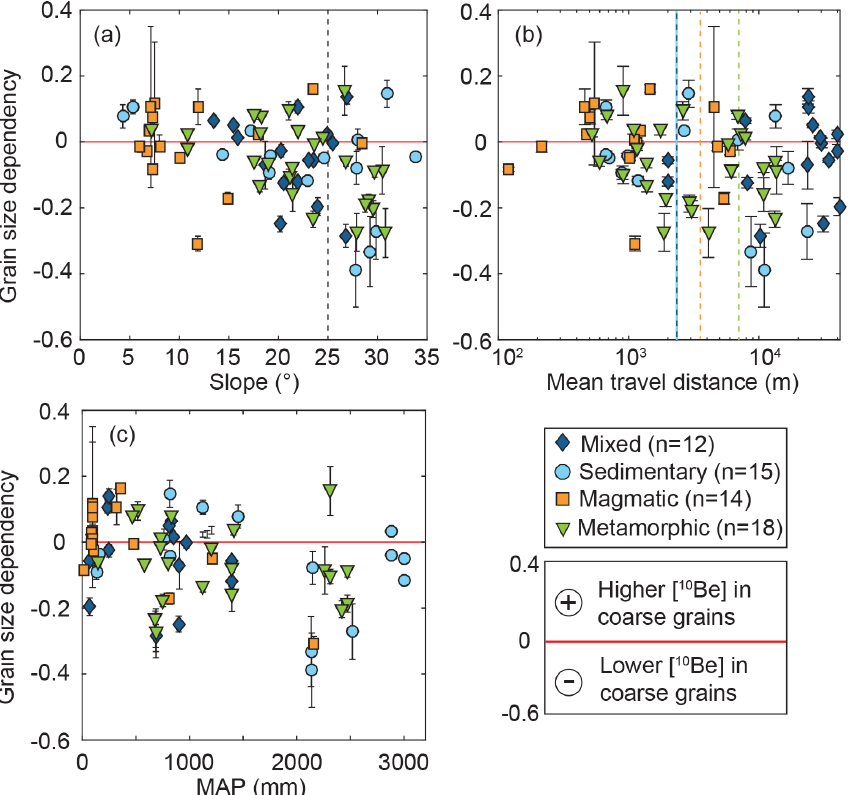
Figure 8. Grain size dependencies of all catchments in the global compilation ( n = 73) as a function of (a) mean basin slope, (b) mean travel distance, and (c) mean annual precipitation (MAP). Coloured symbols depict lithological classes. Grain size dependencies are derived from the slope of a linear fit to the normalized 10 Be concentrations and grain sizes from a sample set, as described in Fig. 4. Dashed lines indicate the threshold hillslope (a) and abrasion thresholds (b) mentioned in the text. Global compilation statistics are provided in Table S4 and Fig.